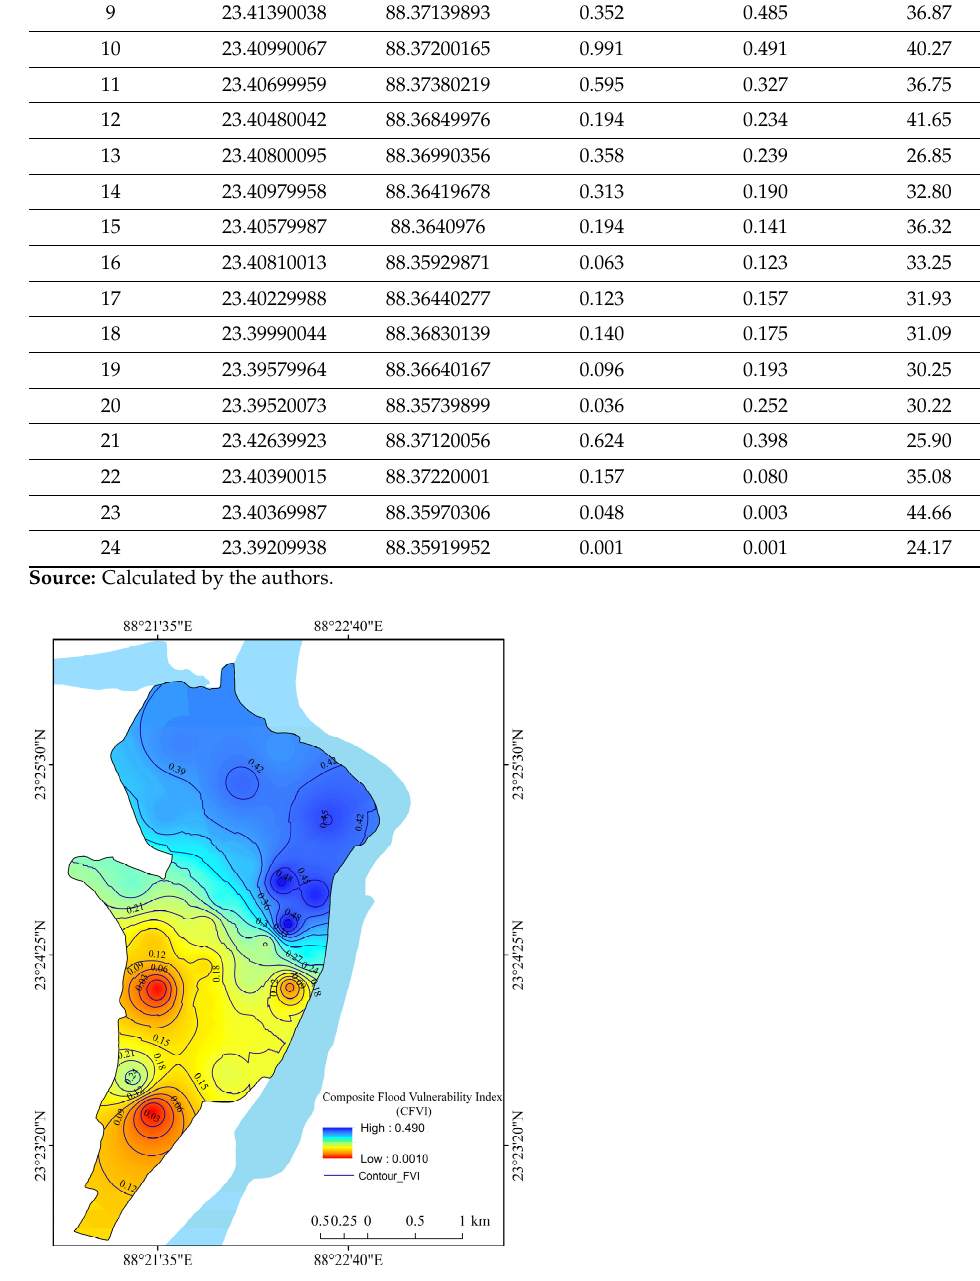
Figure 47. Isoline of CFVI (2015).